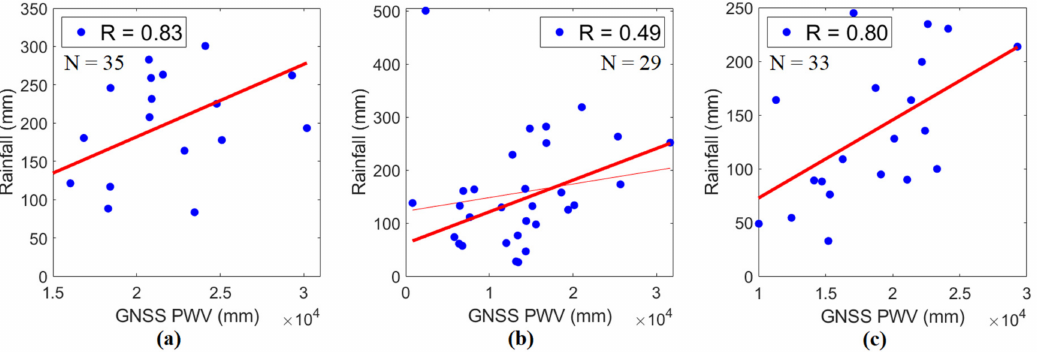
Figure 9. The correlations of monthly total PWV in rainy days and monthly rainfall in ( a ) Quezon City, ( b ) Legaspi, and ( c ) Puerto Princesa from 2015 to